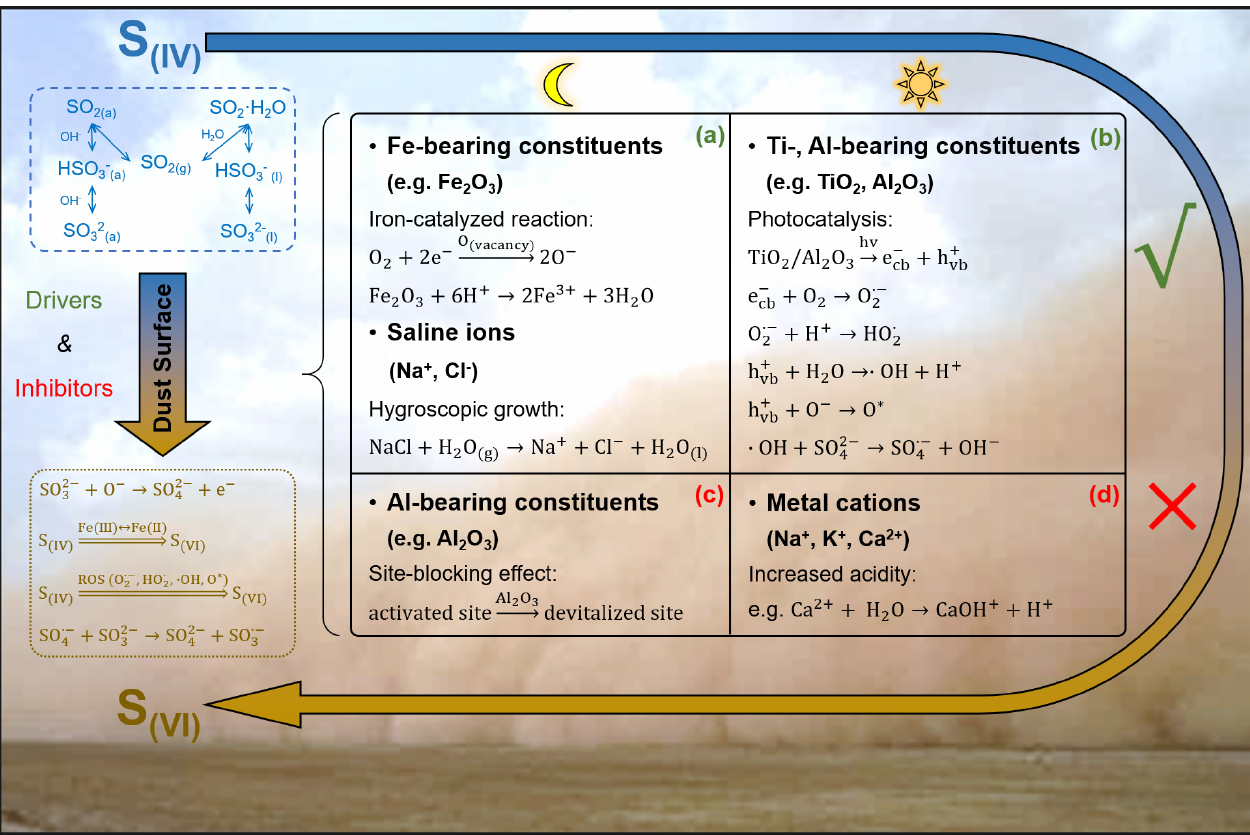
Figure 2. Mechanism illustration of the dust-driven heterogeneous conversion of SO 2 . The heterogeneous reaction of airborne SO 2 on a natural dust surface includes the initial adsorption of gas-phase SO 2 and the later conversion of S (IV) species to S (VI) products. The formed S (IV) species include both adsorbed and dissolved SO 2 , bisulfite, and sulfite (dashed box in blue). The generation of S (VI) products can be attributed to the surface active oxygen (O − ), Fe(III)–Fe(II) redox cycling, reactive oxygen species (ROS), and sulfate radical (SO box in deep yellow). Heterogeneous oxidation is largely influenced by the dust surface drivers and inhibitors, which promote and hinder the heterogeneous procedures, respectively (solid box in black). Dust surface drivers are determined as (a) the Fe-bearing constituents and saline ions (Na + , Cl − ) under dark conditions and (b) the Ti- and Al-bearing constituents under solar irradiation. Dust surface inhibitors are identified as (c) the Al-bearing constituents under dark conditions and (d) the metal cations (Na + , K + , Ca 2 + ) under solar